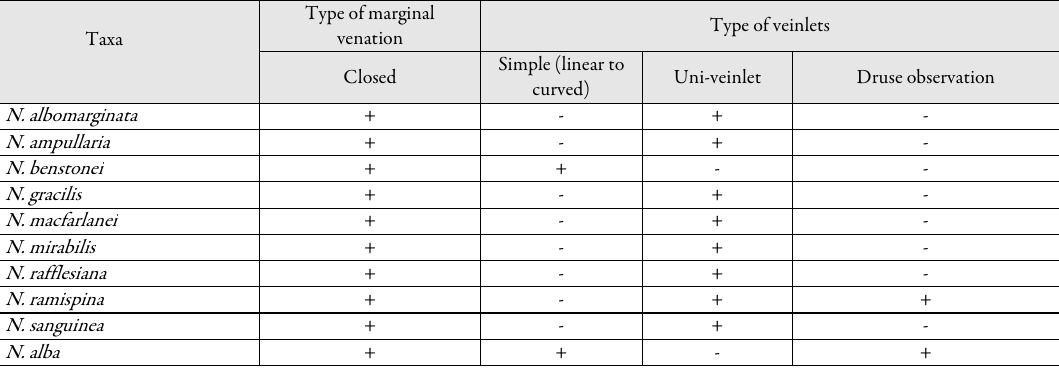
Table 4. Variation in the areolar / marginal venation pattern & druses observation in studied Nepenthes